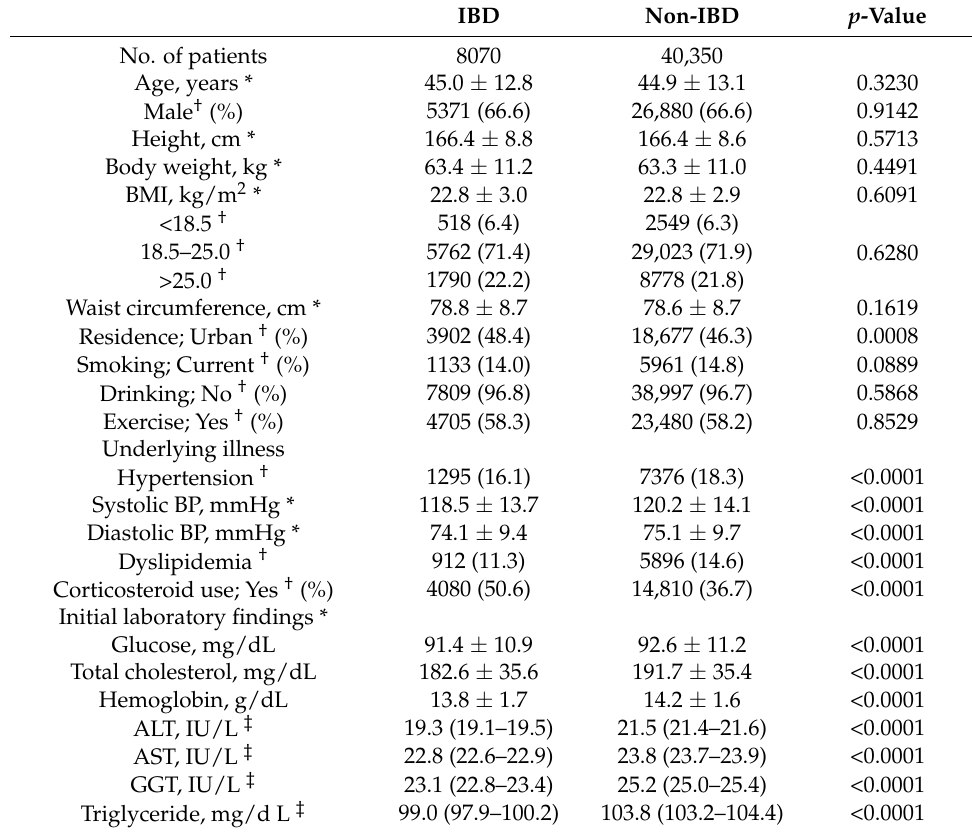
Table 1. Baseline characteristics of the study